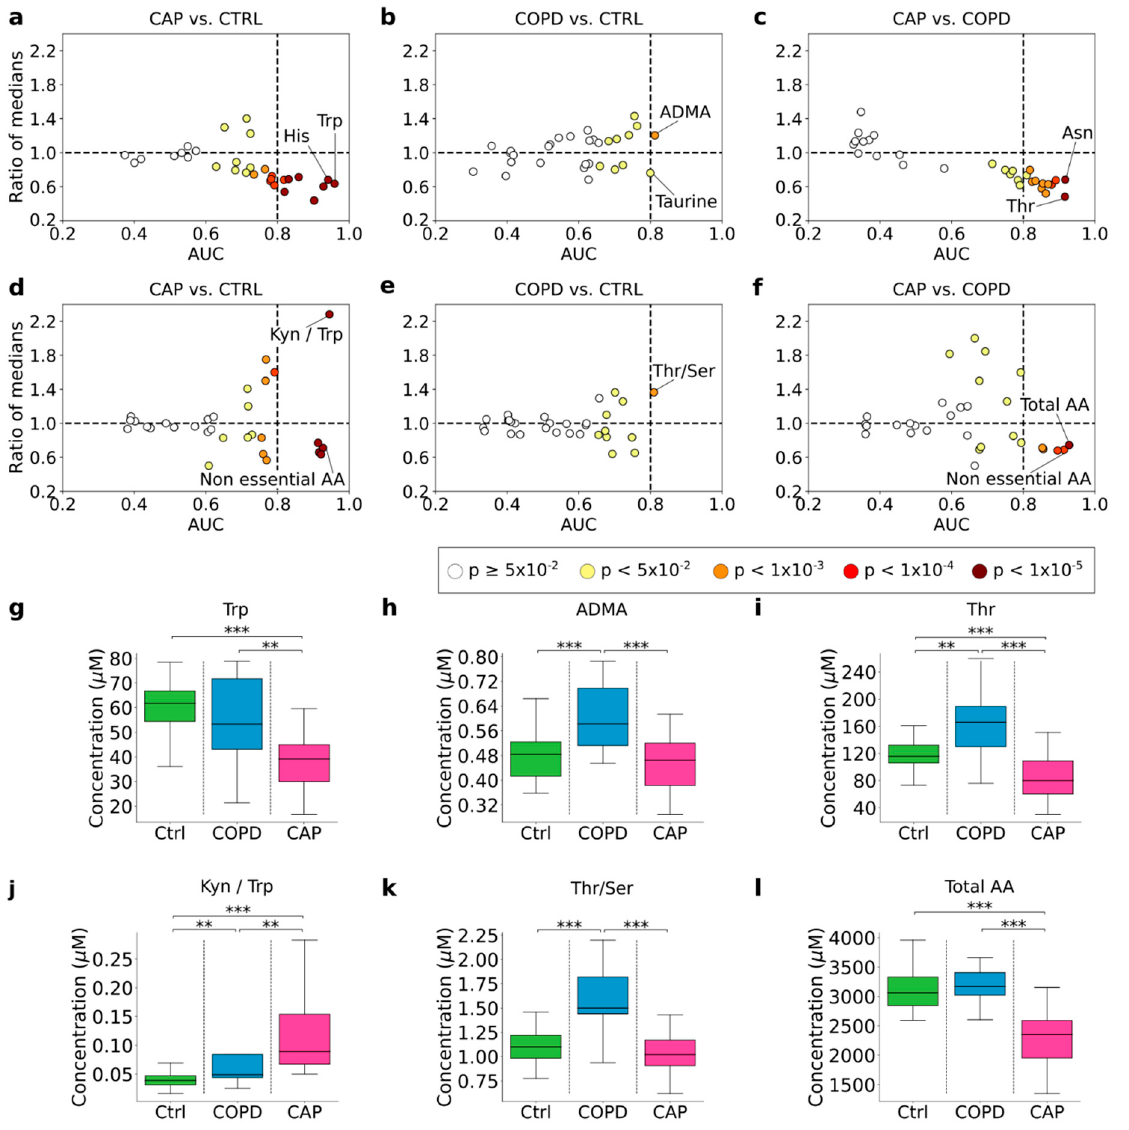
Figure 4. Quantitative ( ROC curve ) biomarker analysis of plasma amino acids and amino acid metabolites in acute CAP and COPD. Differential abundance (ratio of medians, “fold change”; y − axis) is plotted against area under the ROC curve (AUC, x − axis), with fill color darkness indicating the asymptotic significance of the ROC curve. Each dot corresponds to one analyte ( a – c ) or one metabolism indicator ( d – f ). The dotted vertical line marks AUC 0.80, the cut − off for “excellent